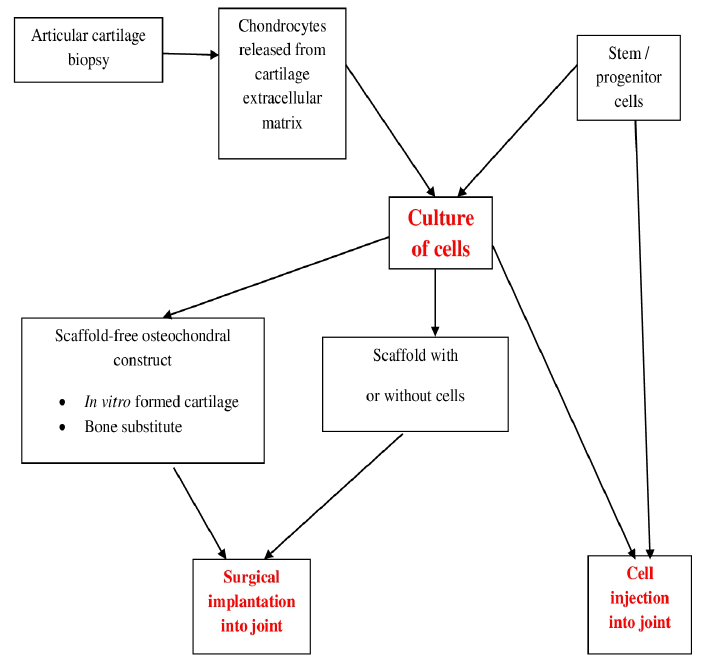
Figure 3. Outline of approaches for the repair of cartilaginous tissue. All methods exhibited can be improved with bioactive effectors or mechanical loading.